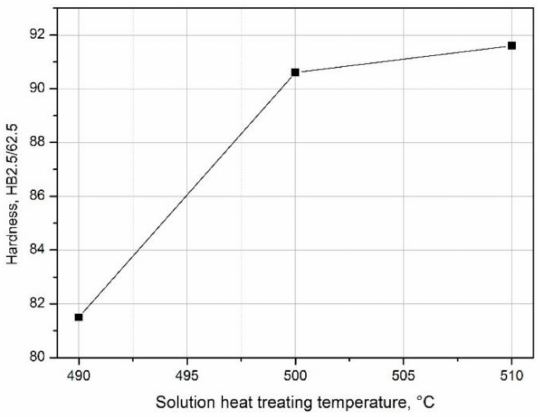
Figure 11. Influence of solution heat treatment temperature on the 2017A alloy